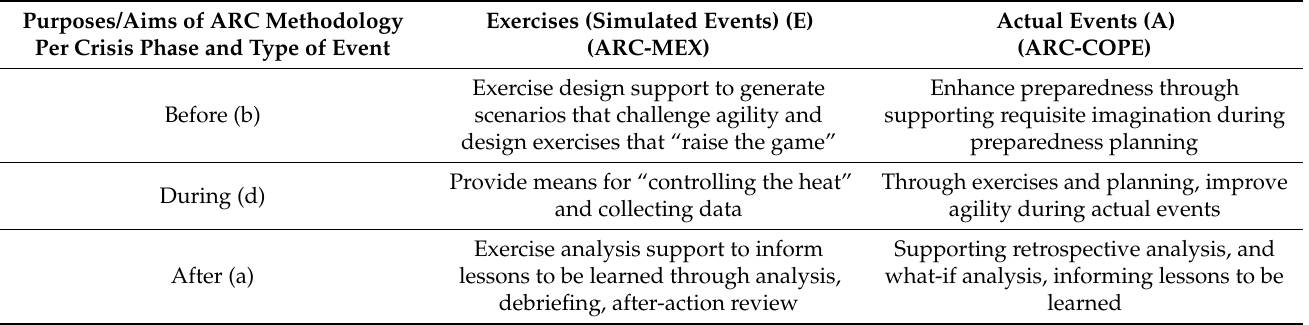
Table 1. Purposes and aims of ARC methodologies ARC-MEX and ARC-COPE per crisis phase and type of